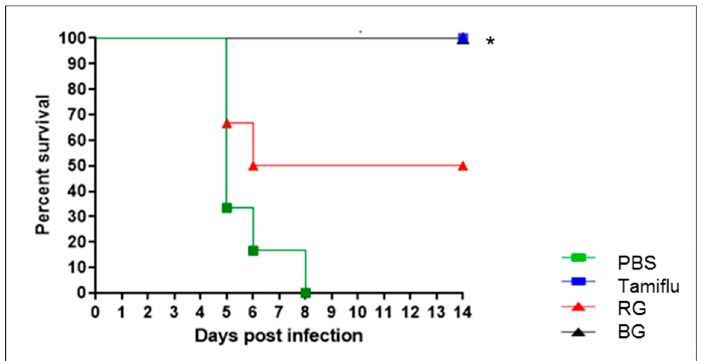
Table 1. The amounts of ginsenosides in BG and RG.